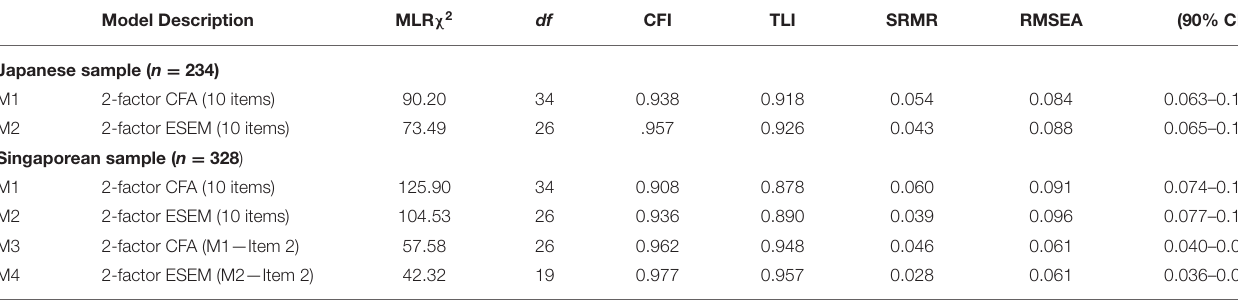
TABLE 2 | Summary of goodness-of-fit statistics for specified models.